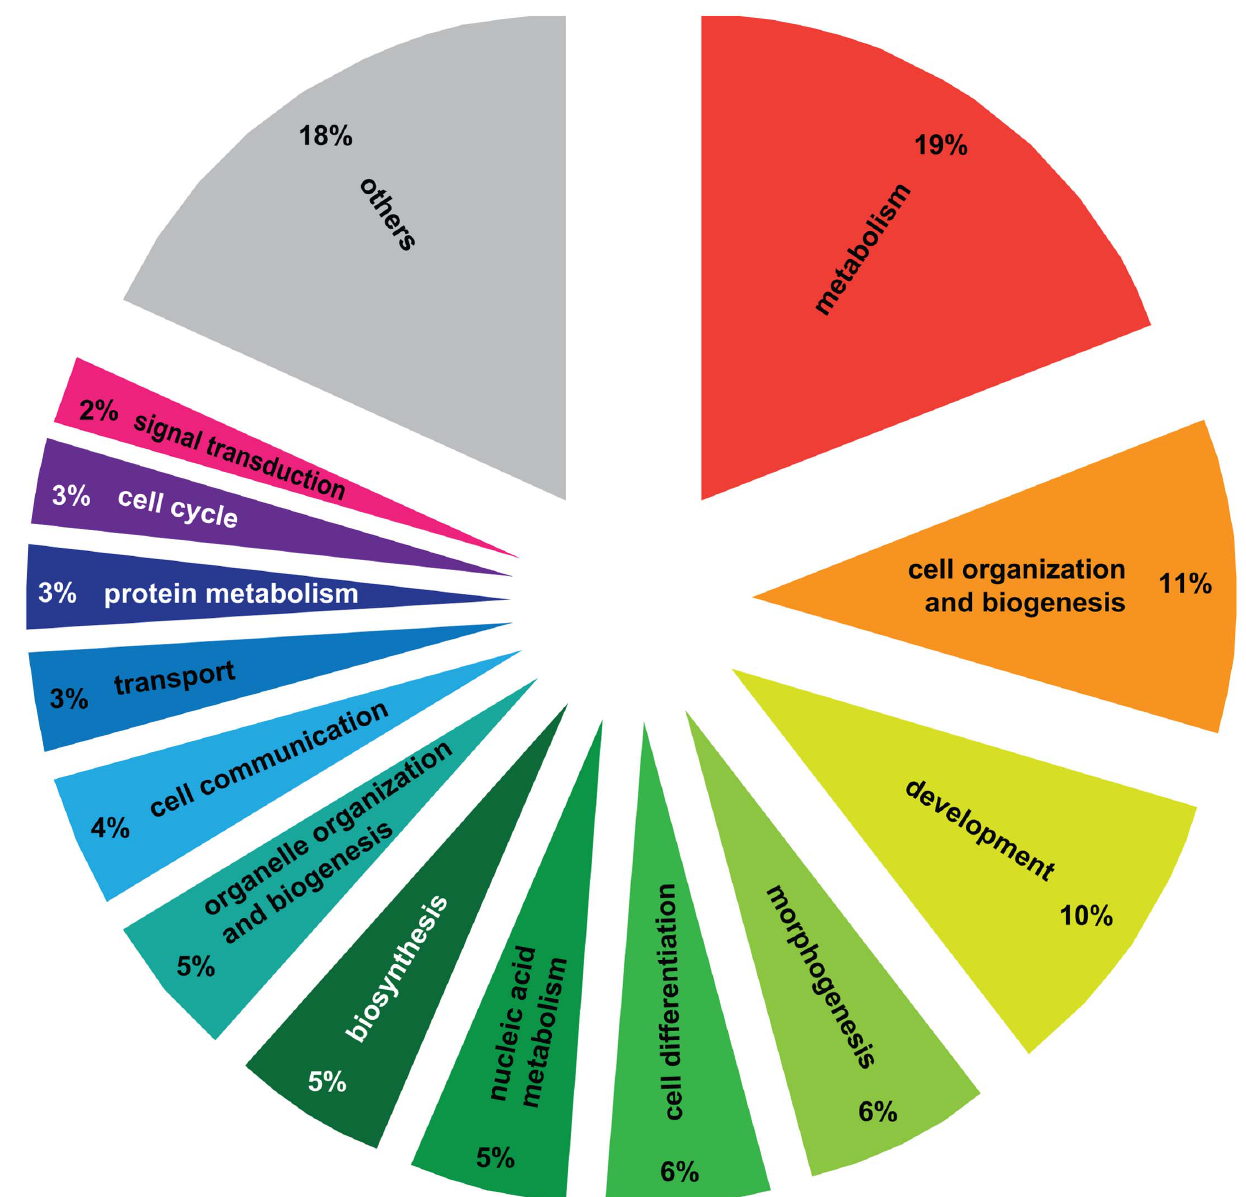
Figure 2. Gene Ontology analysis of genes differentially regulated between haplometrotic and pleometrotic queens. The figure shows the larger functional groups that encompass significantly enriched GO terms resulting from the GO analysis. To obtain this result we overlapped the list of significantly enriched GO terms from experiment 1 (Functional Annotation Chart, P , 0.05) with the GO_slim2 list of the cateGOrizer. Others=larger functional groups encompassing less than 2% of the total number of significantly enriched GO terms (see Table S3 for the complete list of ancestor GO terms).